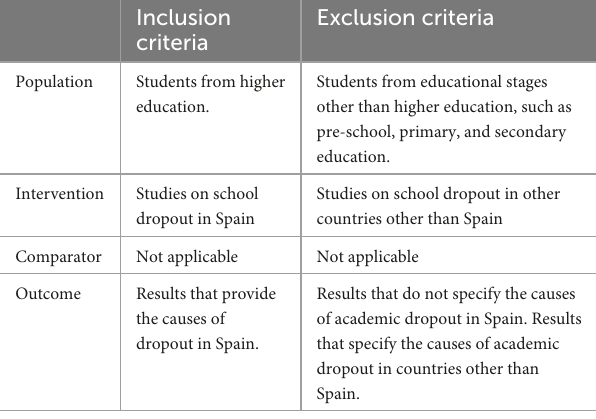
TABLE 3 Inclusion and exclusion criteria according to patient, intervention, comparison, and outcome (PICO) approach. Inclusion